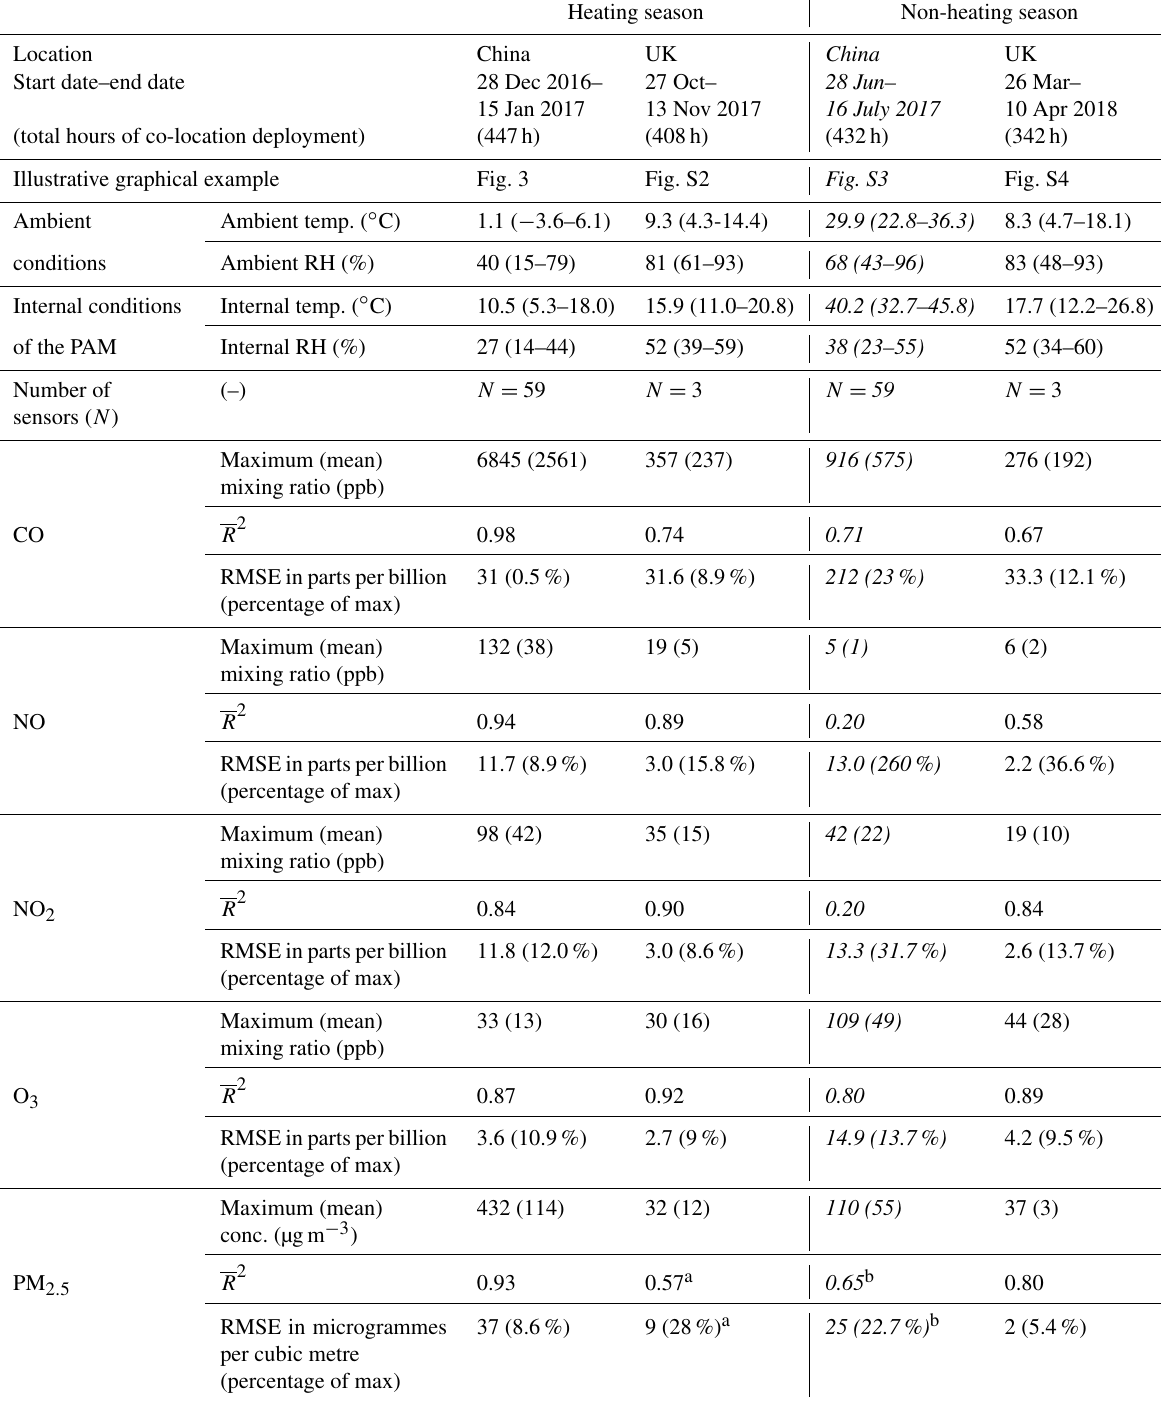
Table 3. Overview of sensors’ performance during outdoor co-locations in China and the UK (7 to 19 days). Median values (range: 5th–95th percentiles) of the ambient temperature and relative humidity (RH), internal temperature and RH of the platform are presented. The 95th percentile of the concentration measurements of the reference over the entire co-location period is given as the maximum concentration for 2 each pollutant. The mean adjusted coefficients ( R ) and root-mean-square errors (RMSEs) indicate the agreement between the measurements of the sensors and reference instruments. The average values of all N sensors for each variable are given. Co-location in China in June is shown in italics as sensors were regularly exposed to temperatures higher than 40 ◦ C where sensors do not show linear temperature responses. The sensor reproducibility for these co-locations is presented in Table